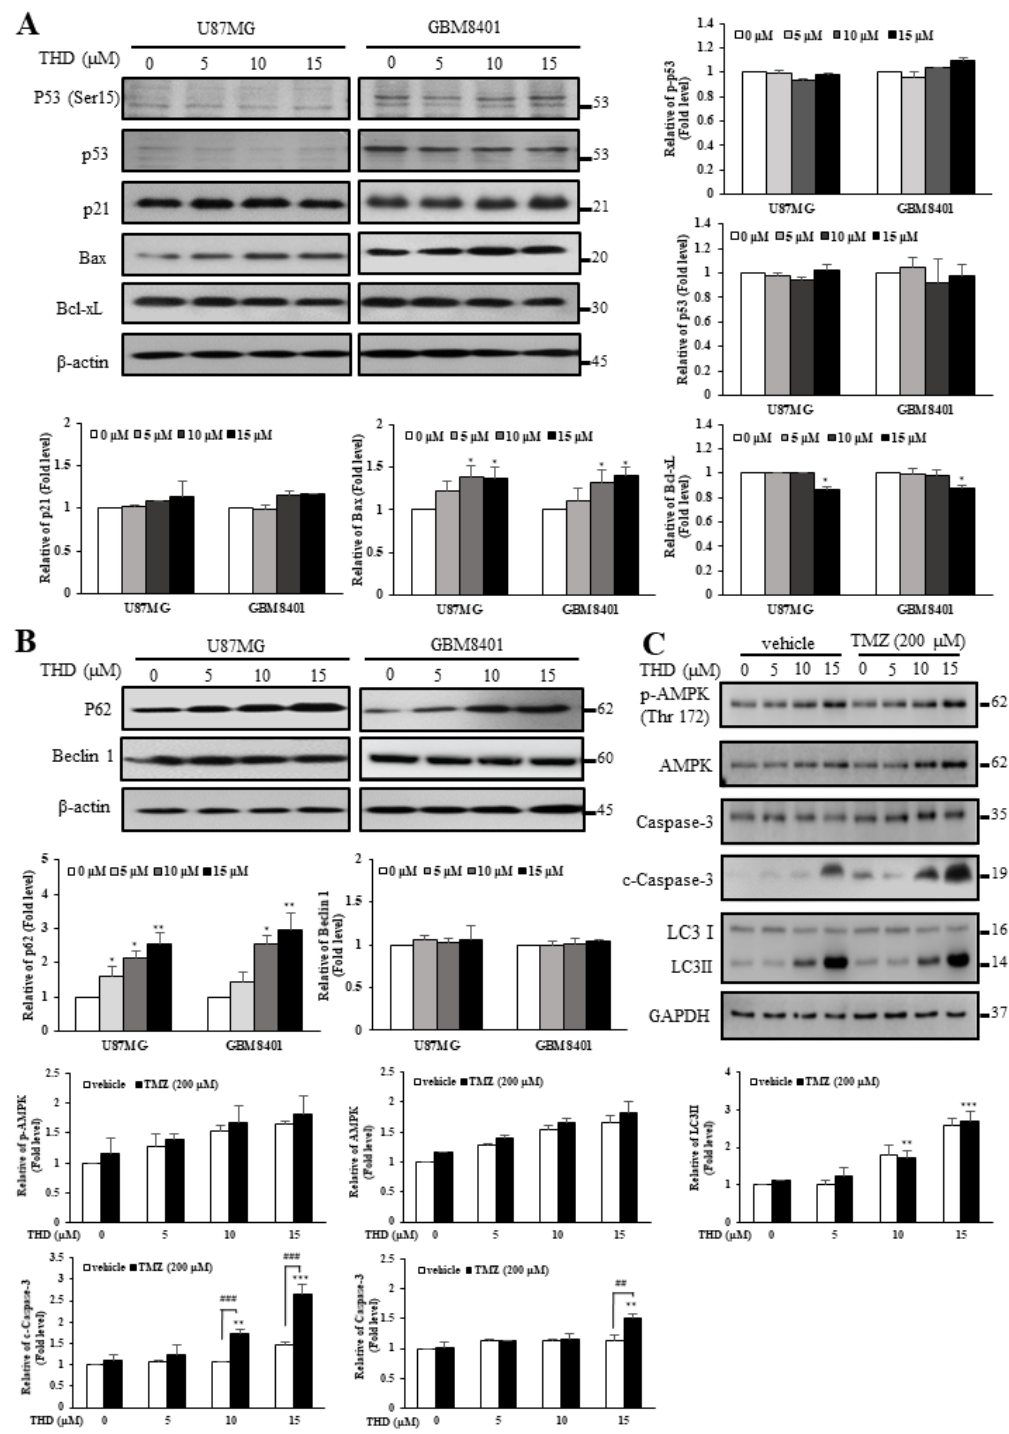
Figure 3. THD induced autophagy and apoptosis in GBM cells. ( A ) Cells were treated with indicated concentrations of THD for 24 h and subjected to Western blotting with antibodies against Bax, Bcl-xL, P53, P53 (Ser15), and p21; ( B ) Cells were treated with THD for 24 h, and Western blotting was performed to evaluate autophagy-related proteins, P62 and beclin-1; ( C ) Combination treatment with TMZ and THD induced AMPK activation and autophagy in GBM cells. U87MG cells were treated with 200 µ M TMZ combined with different doses of THD for 24 h. p-AMPK (Thr172), AMPK, caspase-3, c-caspase-3, LC3-I, and LC3-II were detected using Western blotting. β -actin and GAPDH were used as an internal control. Bar graph represents mean of triplicates ± SD. * p < 0.05, ** p < 0.01, *** p < 0.001 compared with the control group. ## p < 0.01, ### p < 0.001 indicated TMZ (200 µ M) vs. Vehicle.